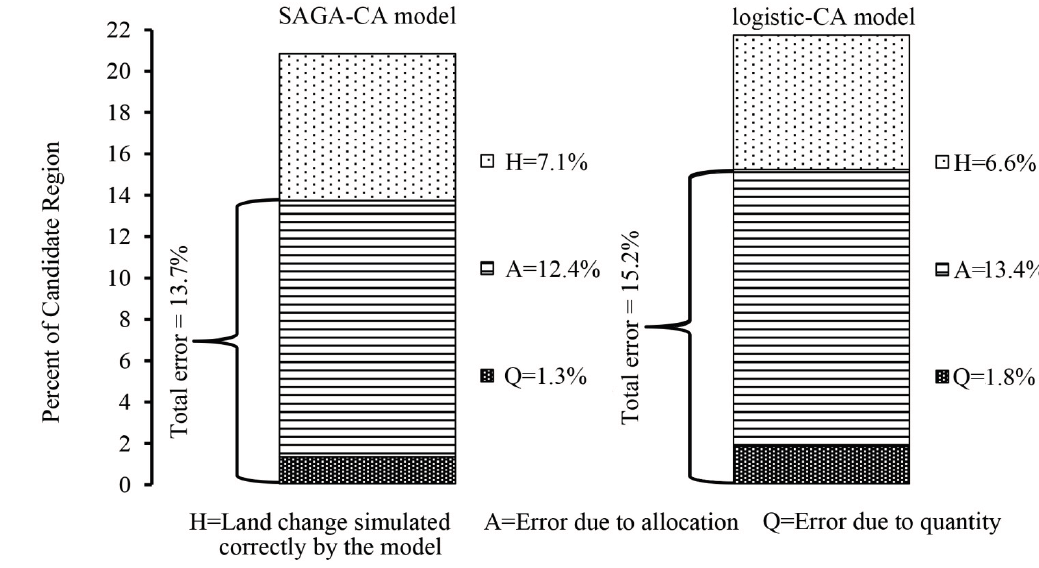
Figure 9. Quantity error, allocation error and hits in the non-urban area of